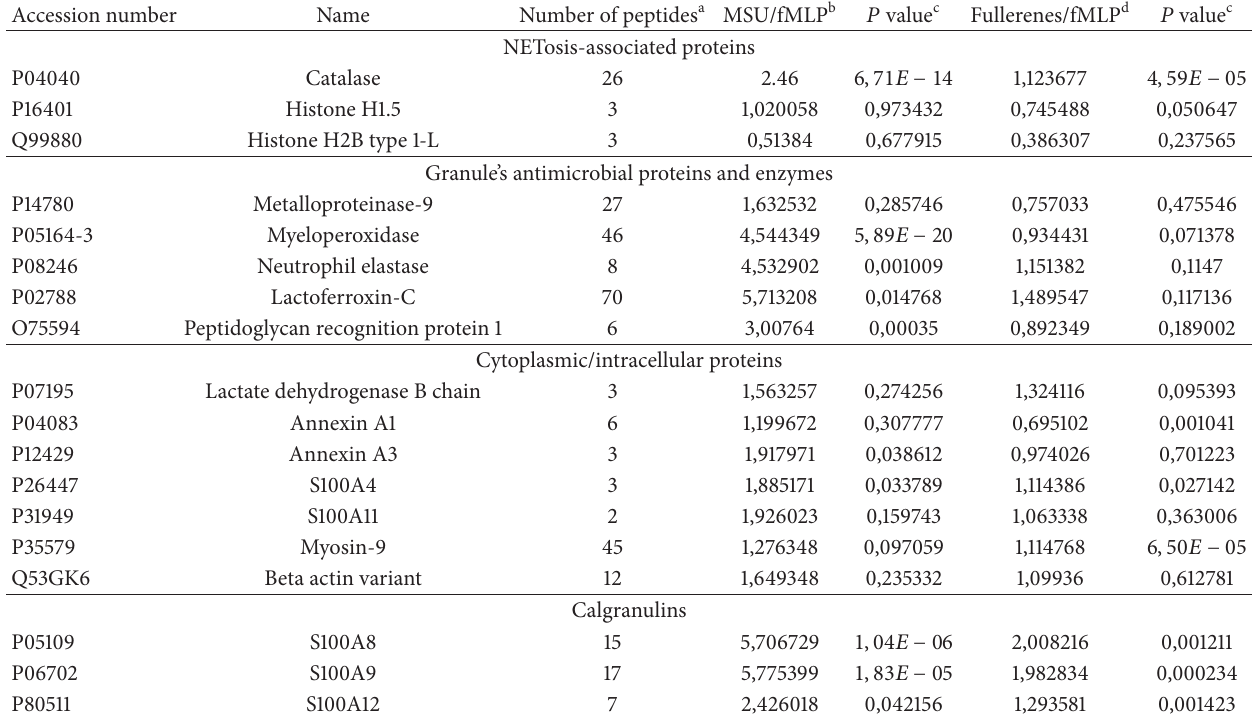
Table 1: Proteomic analysis of proteins secreted by